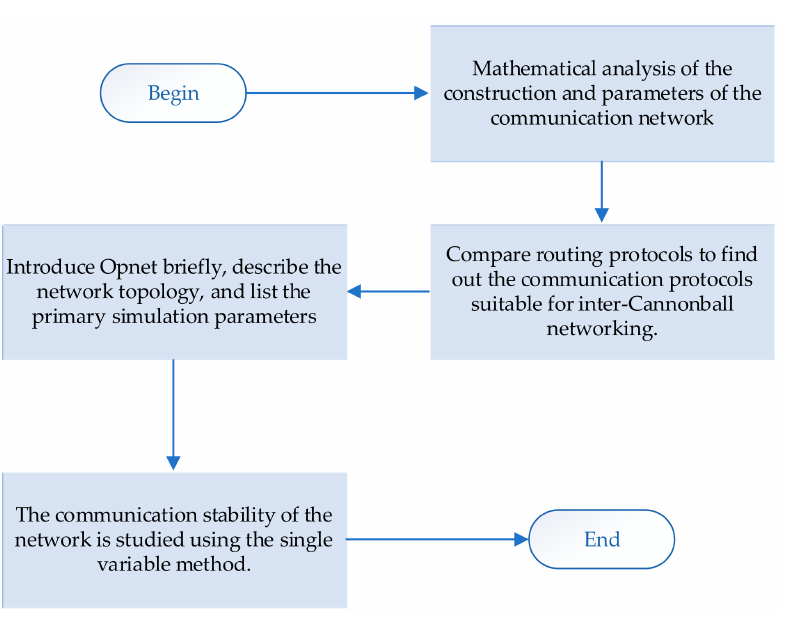
Figure 2. Flowchart of the research